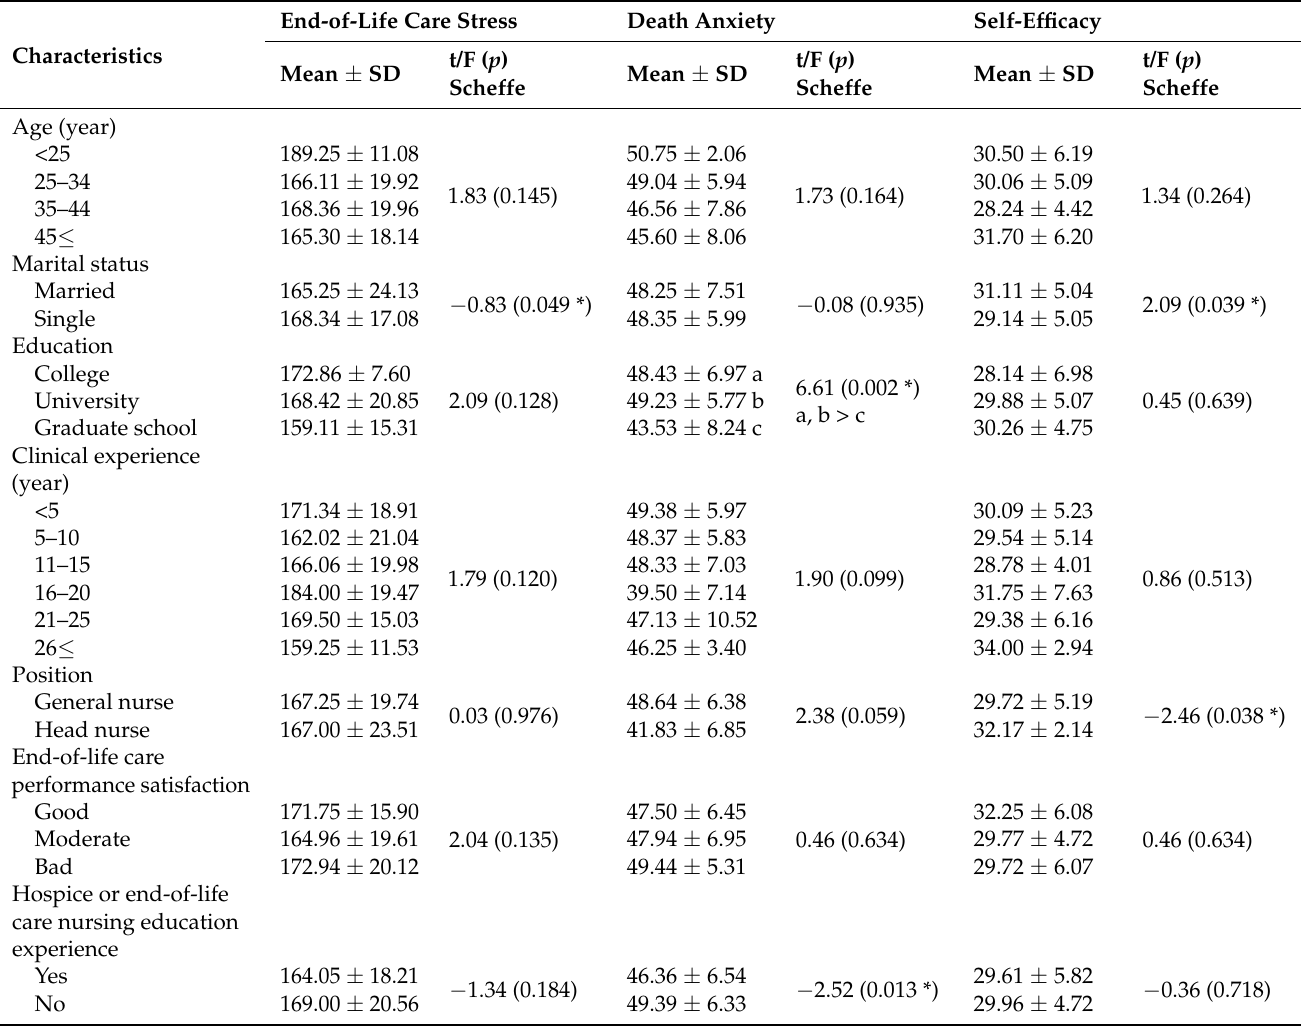
Table 3. Differences of terminal care stress, anxiety about death, and self-efficacy according to general characteristics of the study participants.